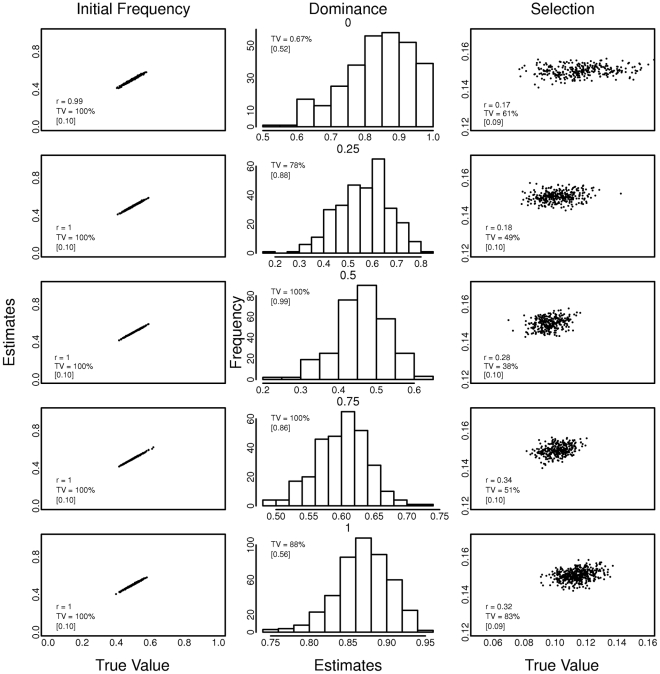
Effect of spatial heterogeneity on estimates of initial allele frequency, dominance and selection parameters.The value of the dominance coefficient was held constant at 0, 0.25, 0.5, 0.75 or 1 in all locations and in every generation, hence there are five rows of results corresponding to each of the 5 values of the dominance coefficient. The value of the selection coefficient (s∼N(0.15, 0.025)) varied between locations, but was held constant over time in each location. The true value is the mean parameter value over all locations. The Pearson correlation coefficient (r) is between estimated and true values. TV is the percentage of the true values that are included in the 95% confidence interval of the estimate. [ ] is the mean width of the 95% confidence interval in all runs.